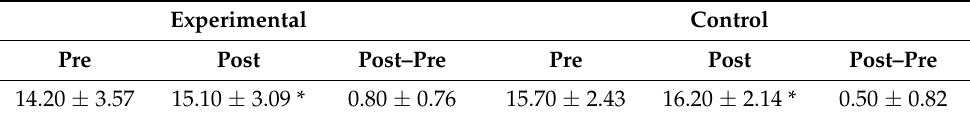
Table 3. Comparison of SATCo (unit: